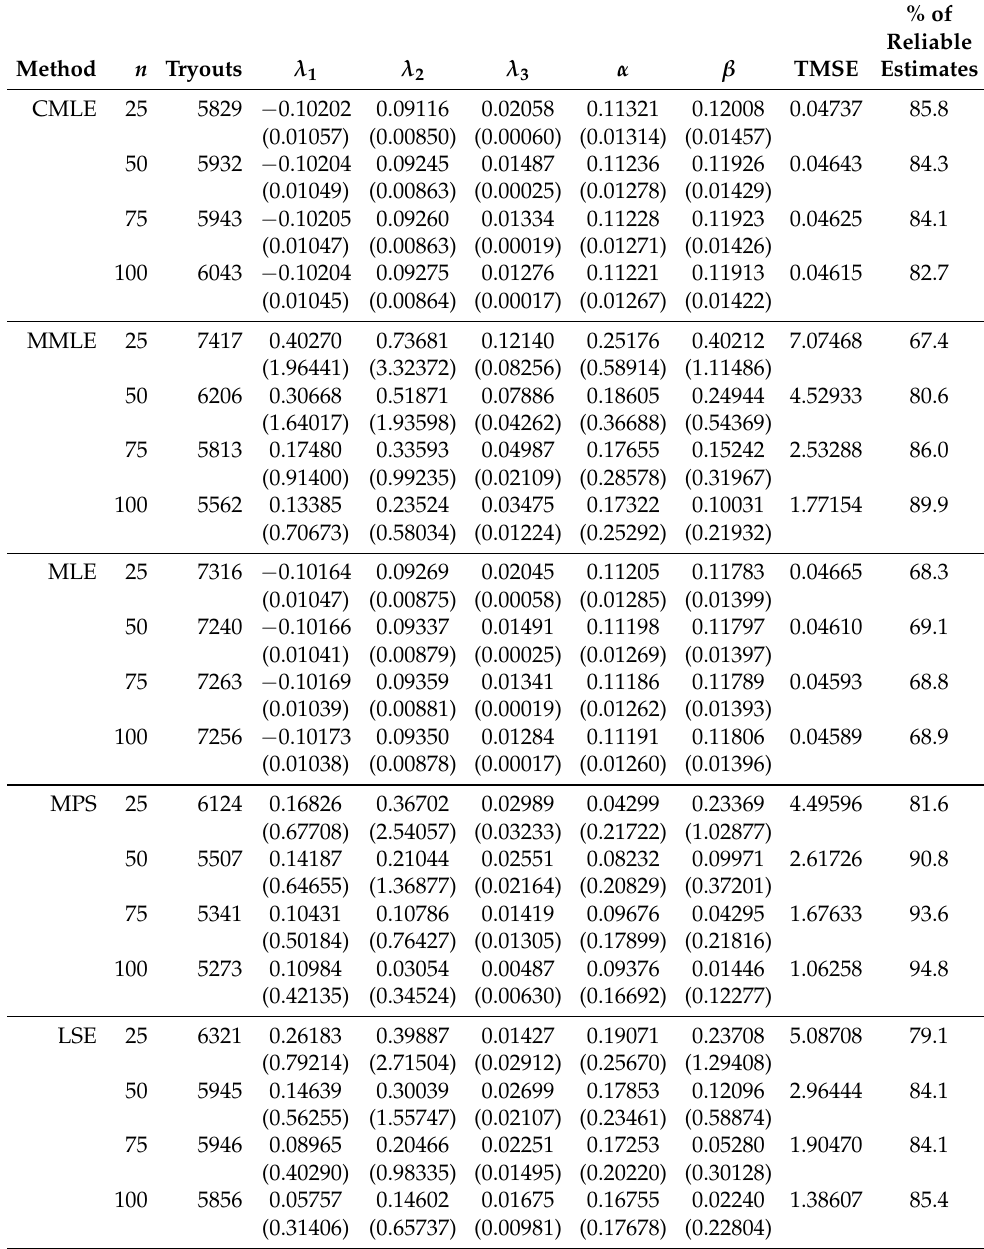
Table 7. Simulated biases and MSEs (in parentheses) of the parameter estimates obtained based